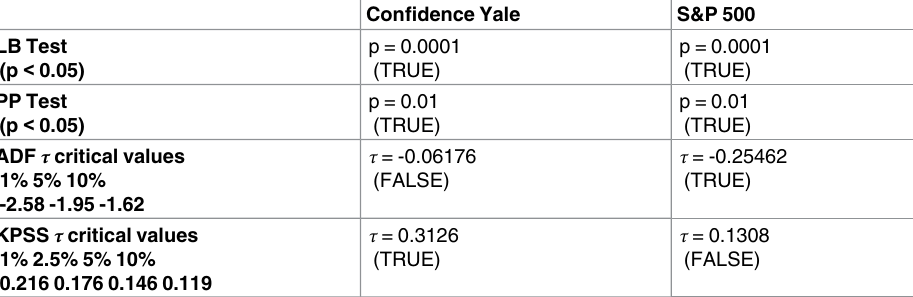
Table 7. Unit root tests for the